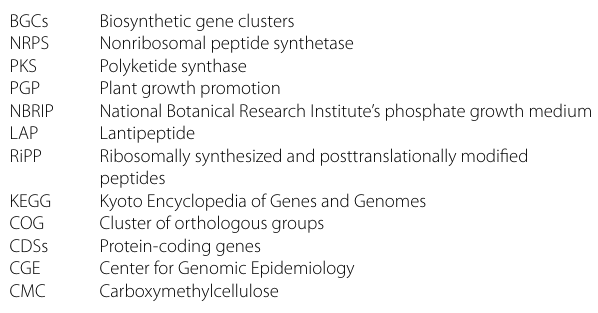
Additional file 2: Table S1. Genes involved in the plant growth-promot- ing traits based on BlastKOALA and RastSEED. Acknowledgements Not